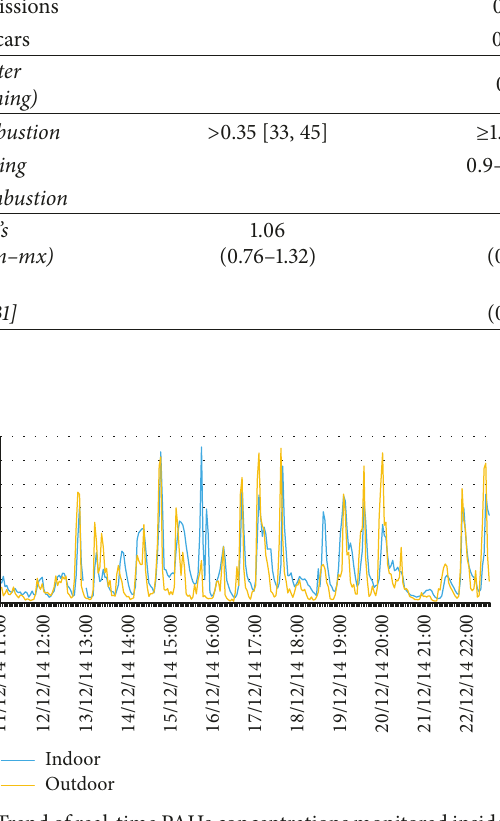
Figure 3: Trend of real-time PAHs concentrations monitored inside and outside the investigated